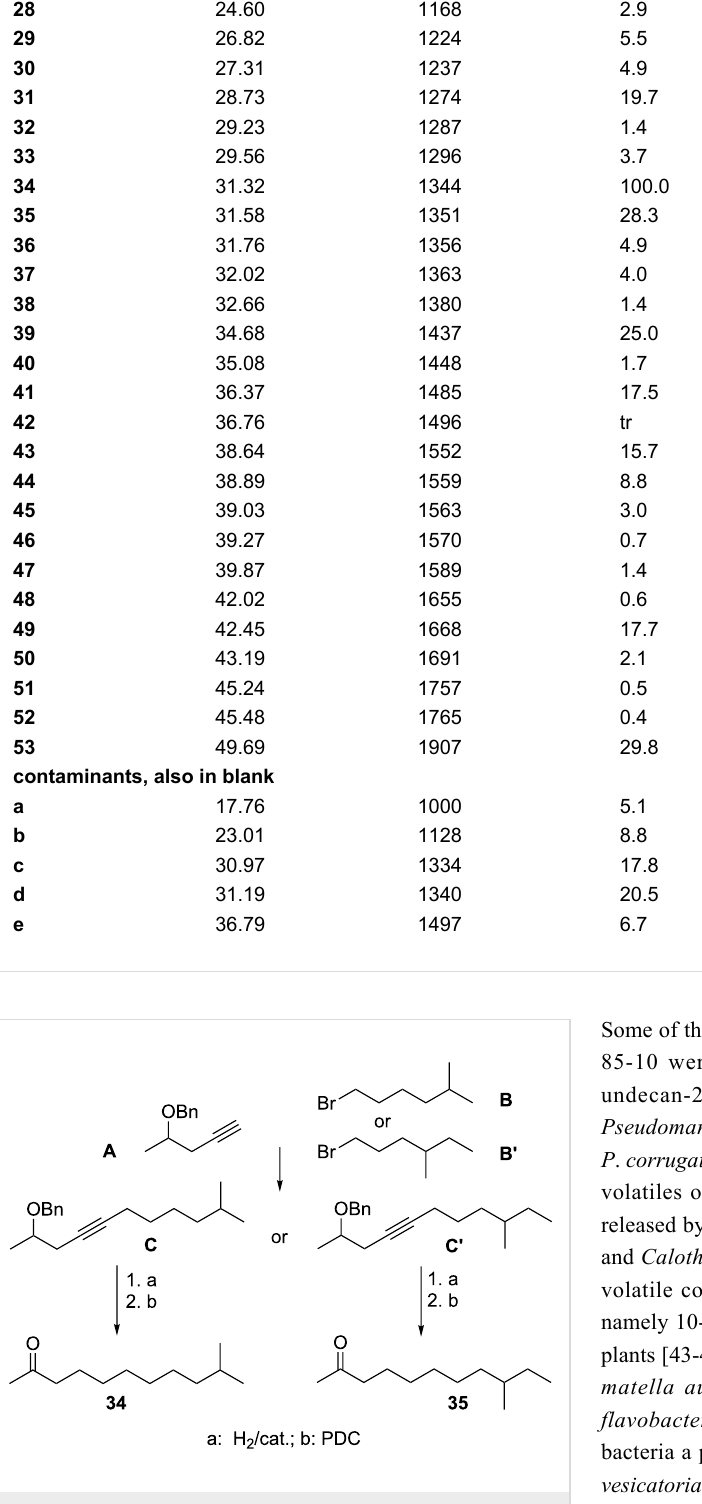
Scheme 1: Synthesis of 10-methylundecan-2-one ( 34 ) and 9-methyl- undecan-2-one ( 35